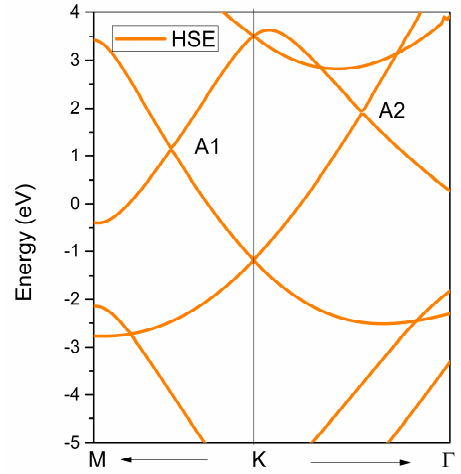
Figure 4. Calculated band structure of YB 2 without considering spin-orbit coupling (SOC.) The Fermi level energy is set at zero.